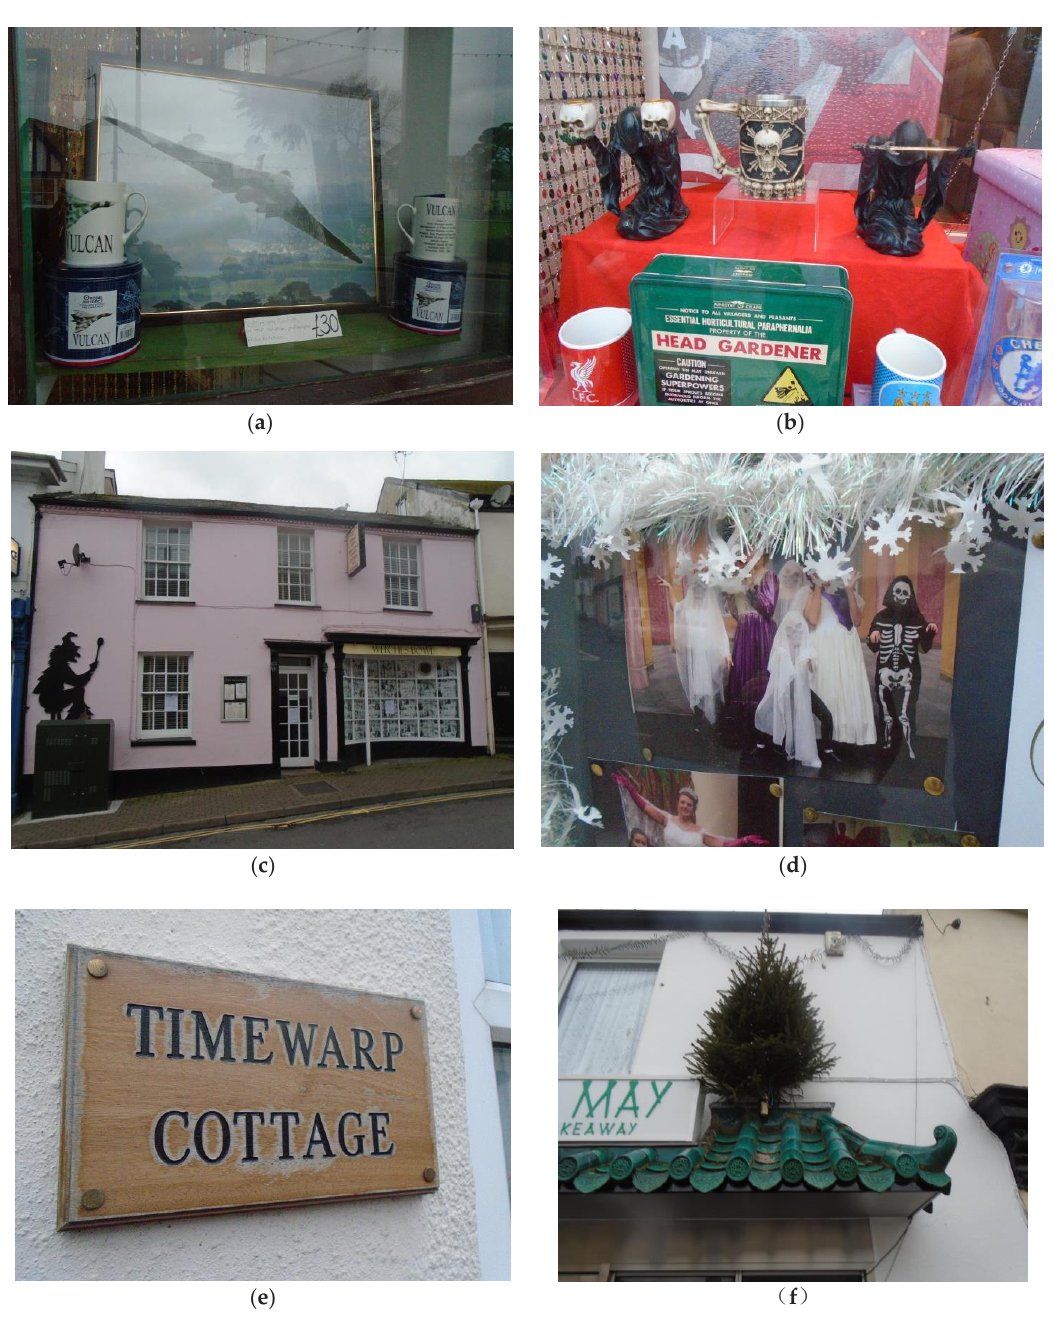
Figure 28. ( a ) Nuclear bomber mementos; ( b ) Gothic ornaments; ( c ) Witch image; ( d ) Halloween costumes; ( e ) House name; ( f ) Christmas tree.